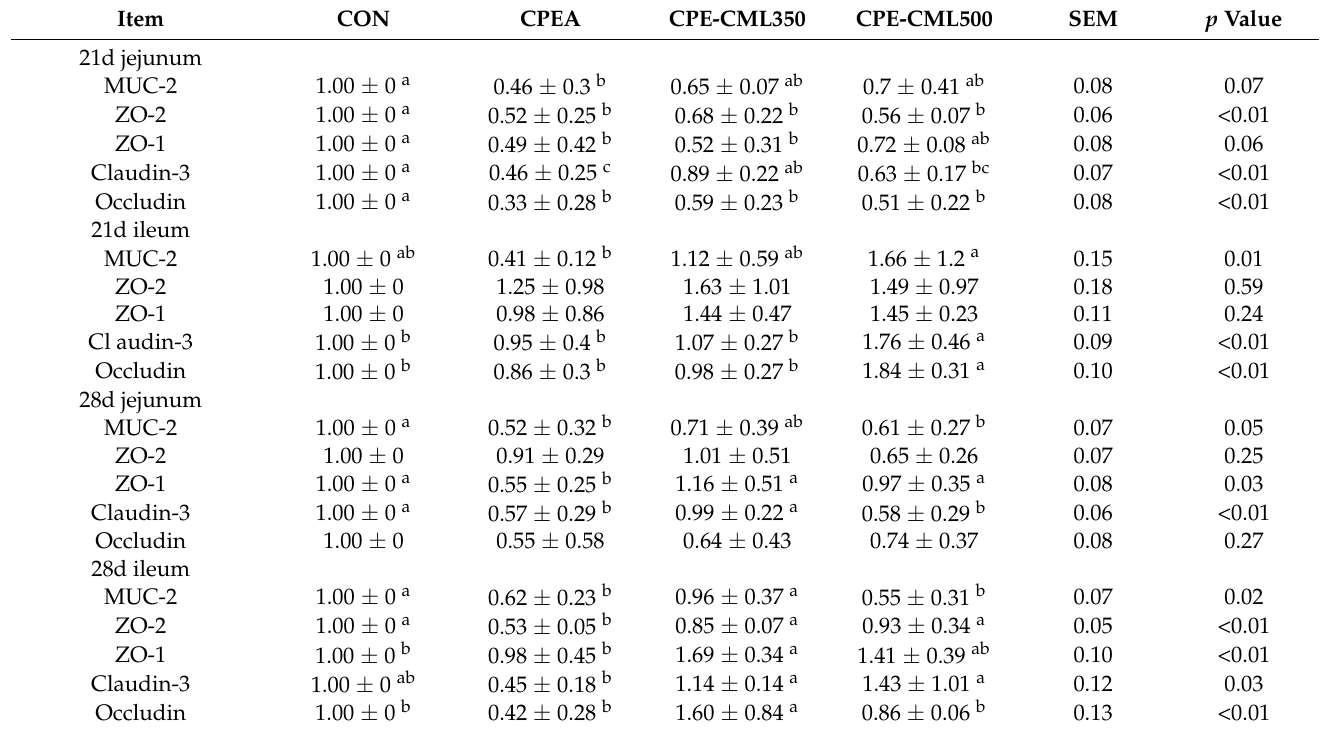
Table 4. Intestinal mucosal barrier